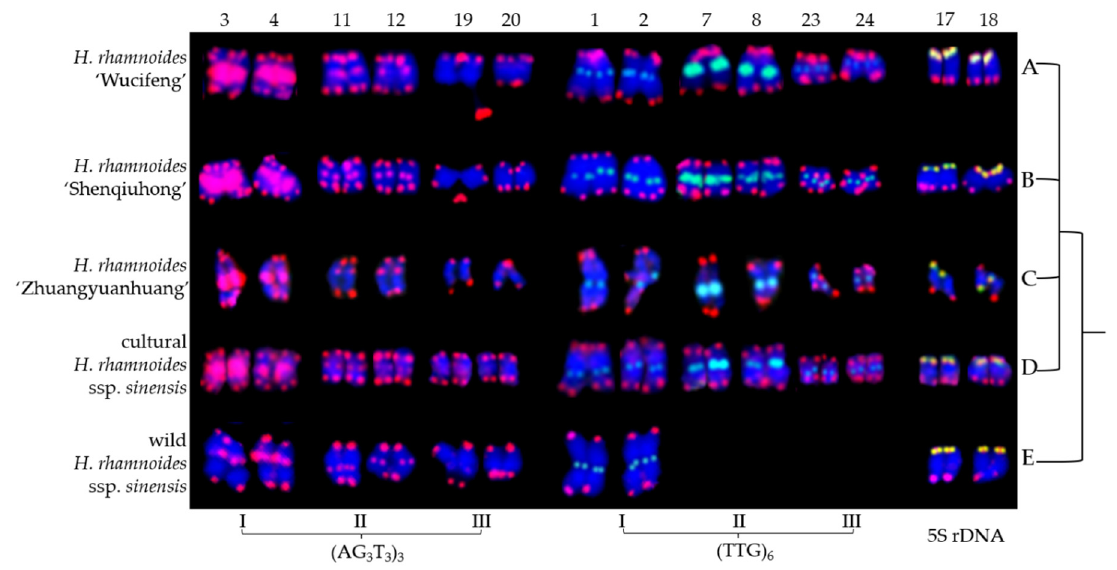
Figure 6. Chromosomes of Hippophaë rhamnoides identified using (AG 3 T 3 ) 3 , (TTG) 6 , and 5S rDNA cut from Figure 4. ( A ) Hippophaë rhamnoides ‘Wucifeng’, ( B ) H. rhamnoides ‘Shenqiuhong’, ( C ) H. rham- noides ‘Zhuangyuanhuang’, ( D ) cultural H. rhamnoides ssp. sinensis , and ( E ) wild H. rhamnoides ssp.